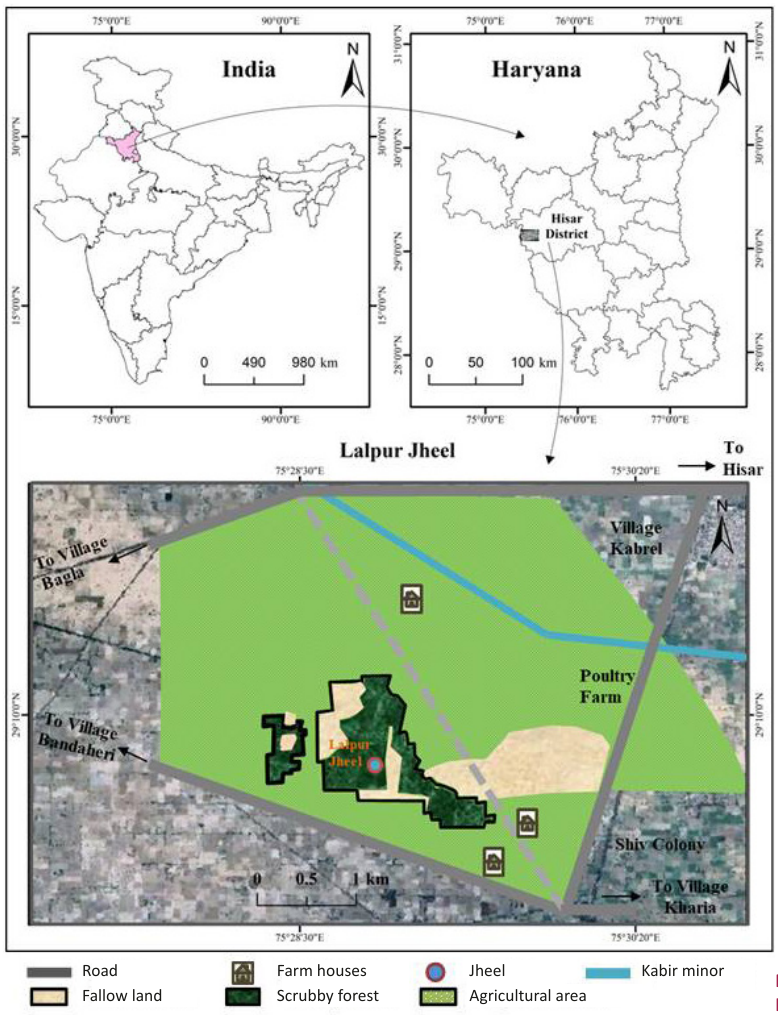
Figure 1. Lalpur Jheel, Dobhi Village in district Hisar, Haryana (India).